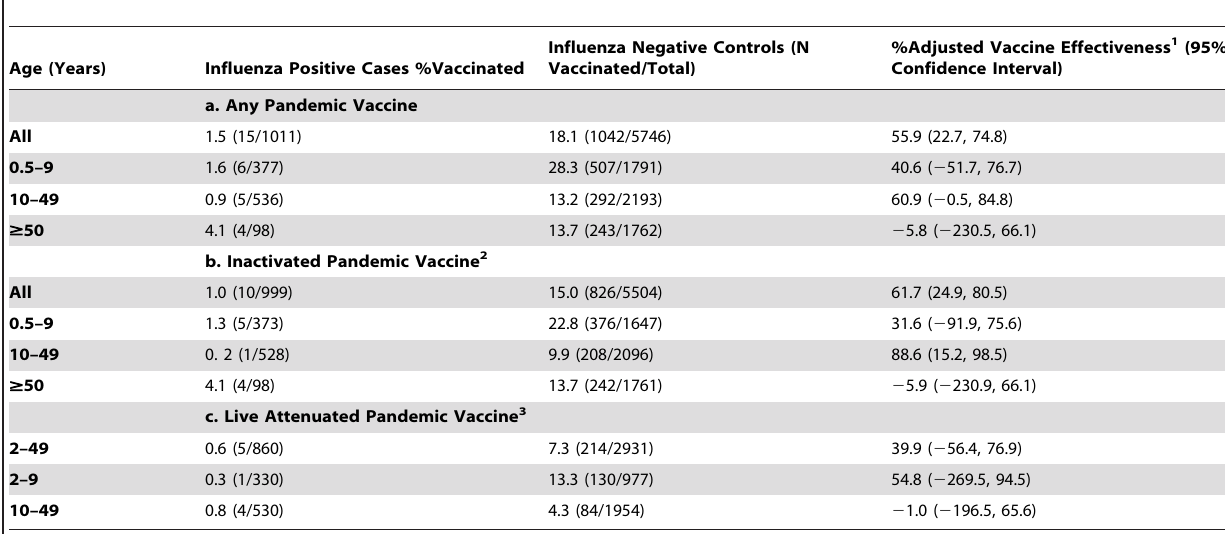
Table 3. Percent Vaccinated more than 14 Days Prior to Illness Onset by Case Control Status and Adjusted Vaccine Effectiveness, by Age Group and Vaccine Type.